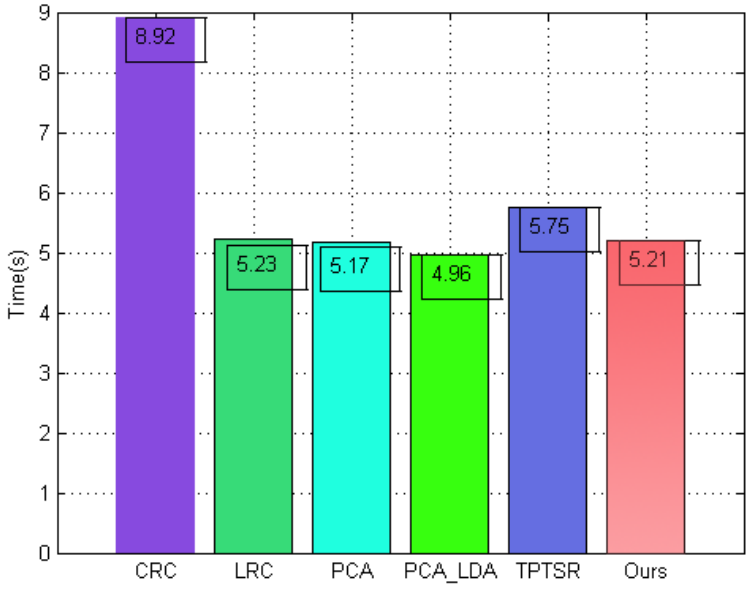
Figure 20. Running time of different